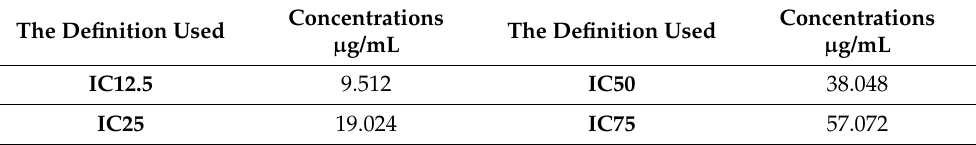
Table 1. Concentrations used in the experiments and their